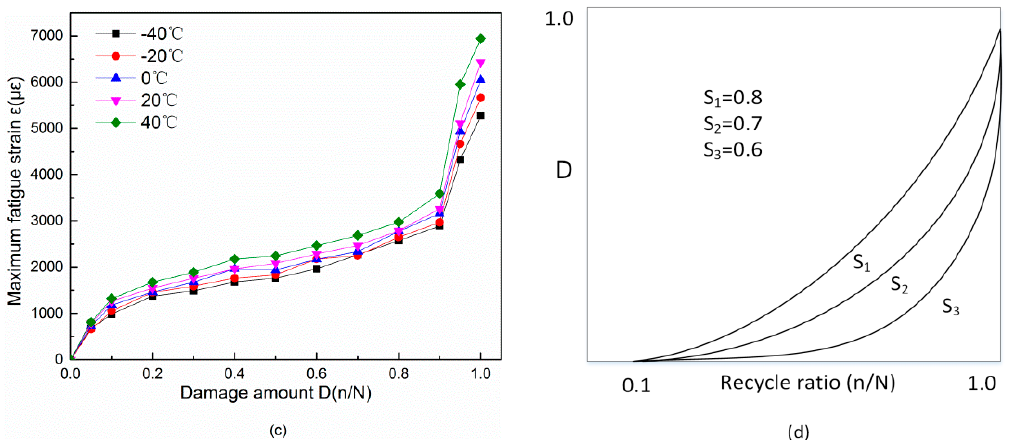
Figure 9. The D - ε curves of CNFPUC at different stress levels. ( a ) D - ε curve at stress level 0.6; ( b ) D - ε curve at stress level 0.7; ( c ) D - ε curve at stress level 0.8; ( d ) D - n / N trend diagram.